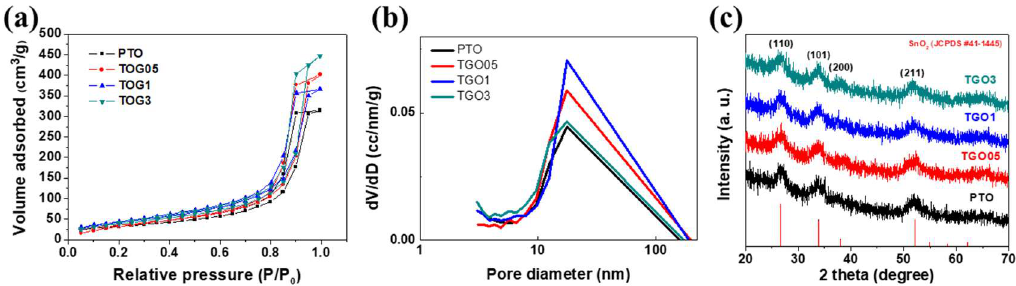
Figure 1. ( a ) Brunauer–Emmett–Teller isotherms, ( b ) Barrett–Joyner–Halenda graph and ( c ) X-ray diffraction spectra of pristine SnO 2 aerogel (PTO) and SnO 2 aerogel/reduced graphene oxide (rGO) nanocomposites with different rGO loadings (0.05 wt.%: TGO05; 0.1 wt.%: TGO1; 0.3 wt.%: TGO3).